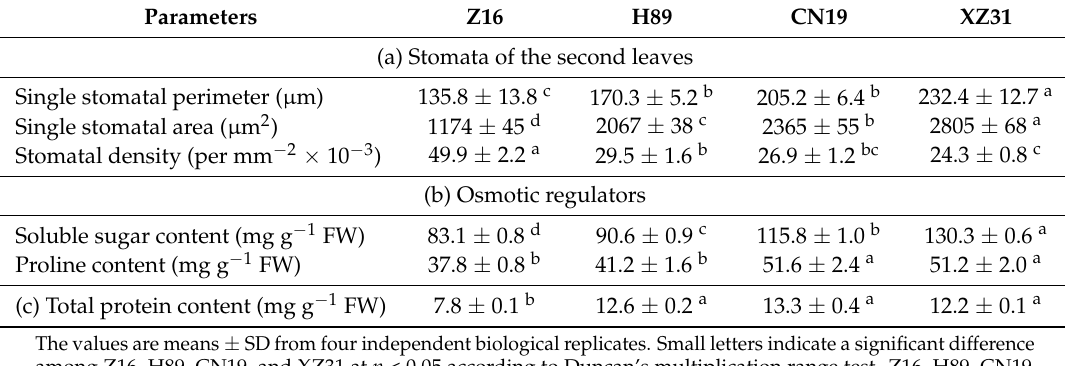
Table 2. Stomata of the second leaf and osmotic regulators in Z16, H89, CN19, and XZ31.